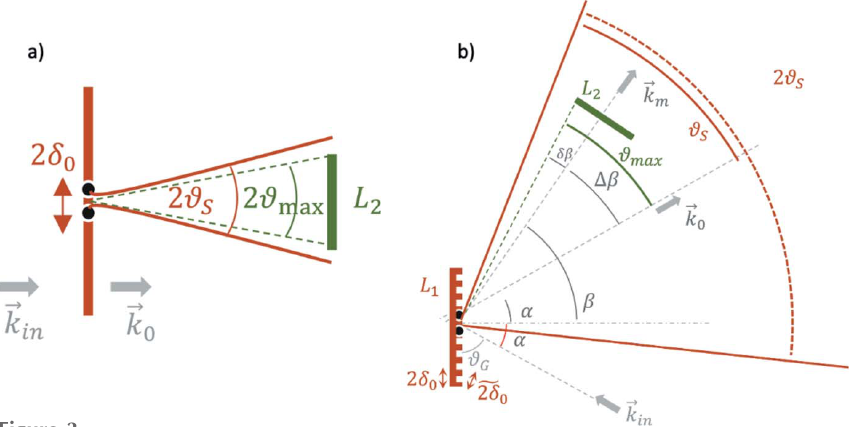
Figure 3 Diffraction-based models for finding the grid spacing (cid:9) 0 . ( a ) The angle in transmission geometry, and ( b ) diffraction from a (reflection) grating of radiation impinging along k in and exiting along k m . 2 ~ (cid:9)(cid:9) is the slit width seen by the incident 0